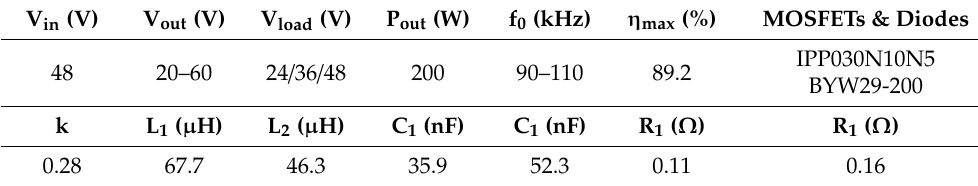
Figure 11. ( a ) Simplified circuit of the e-bike wireless charging system. ( b ) Waveforms of the primary and secondary voltages and currents. Table 3. Values of the components of the e-bike wireless charging system.